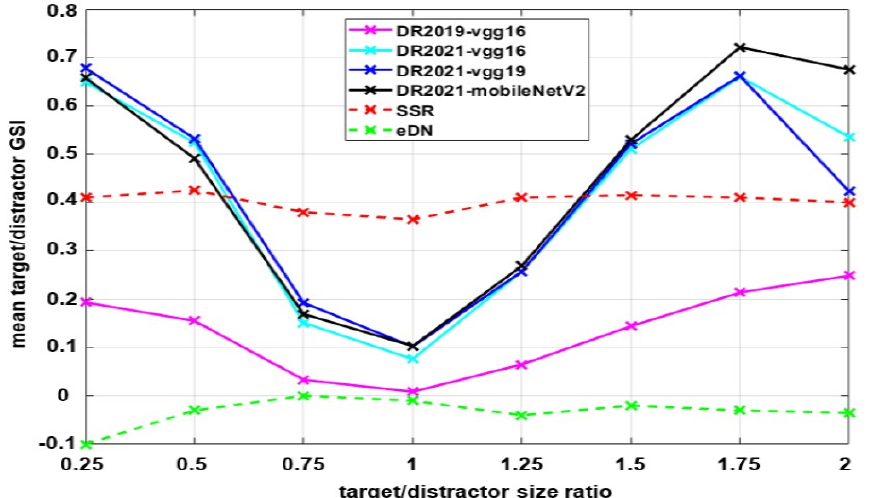
Figure 14. The GSI score for size target/distractor size ratio. Best classical (red dotted line) and deep learning models (green dotted line) along with the DeepRare family